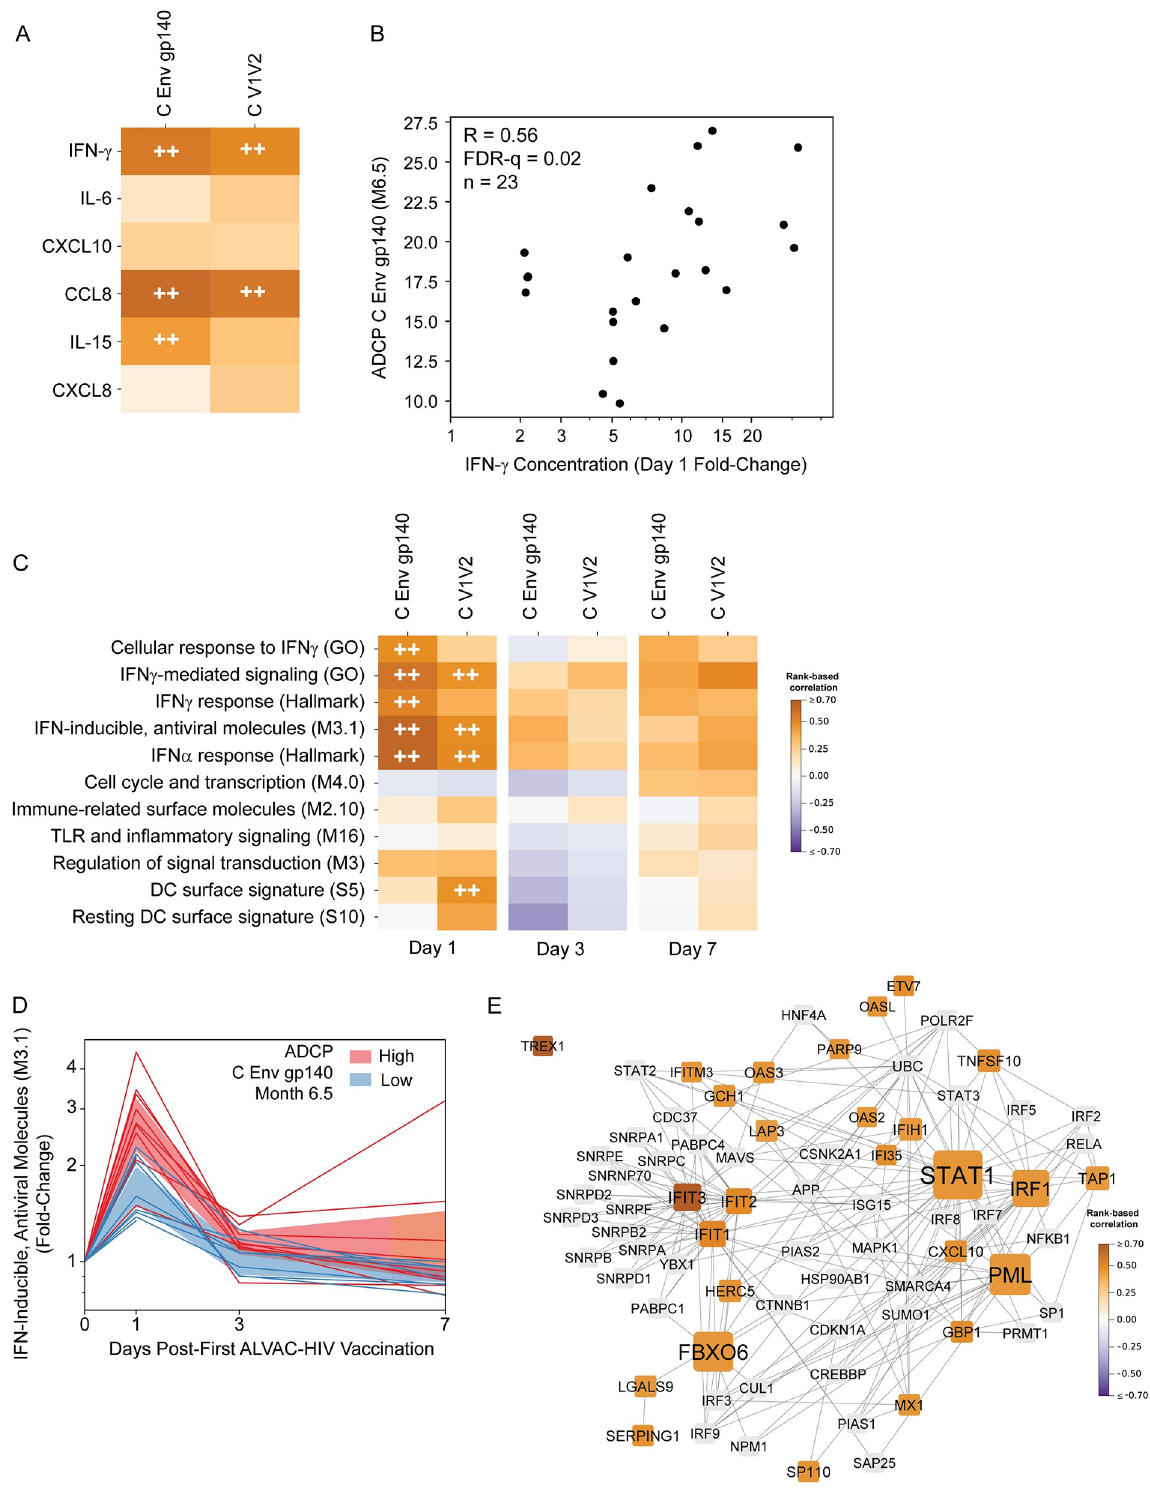
Fig 4. Strong associations between Day 1 changes in gene expression and Month 6.5 Env-specific antibody-dependent cellular phagocytosis (ADCP) responses. A ) Heatmaps represent the strength of rank-based correlations of fold-change in serum cytokine concentrations with Month 6.5 ADCP responses. HIV-1 Env ADCP antigens are shown in columns. For detailed antigen names, see Materials